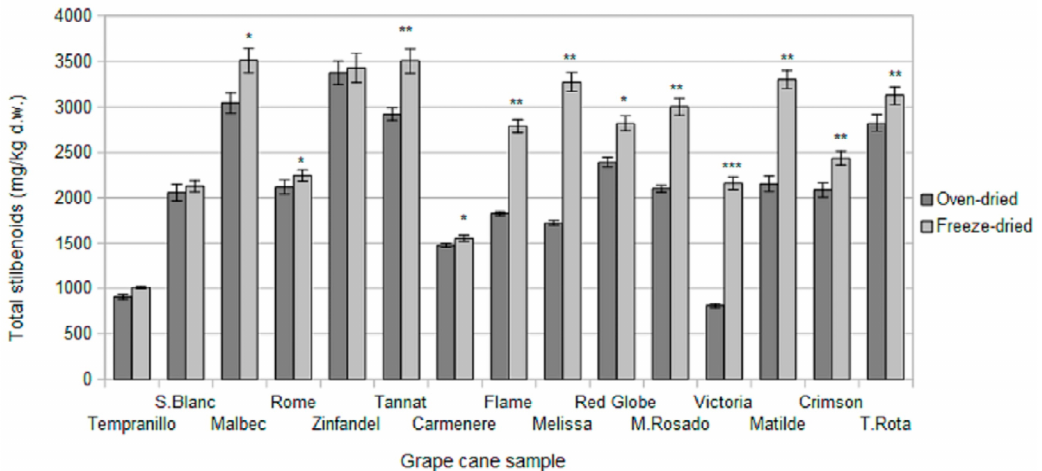
Figure 2. Total stilbenes in different assayed drying processes of grape canes. Bars with * symbol are significantly different at significance levels. * p < 0.05, ** p < 0.01 and *** p < 0.001.